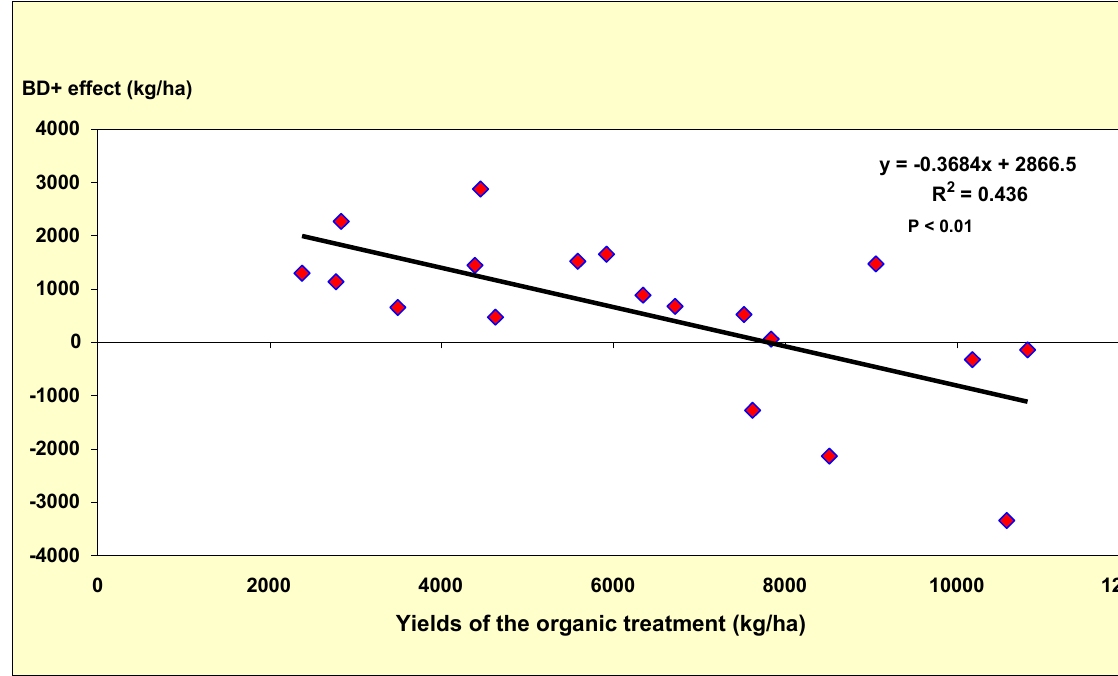
Figure 4: Effects of the BD + NCP treatment relative to organic on the yields of maize (1994-1998)